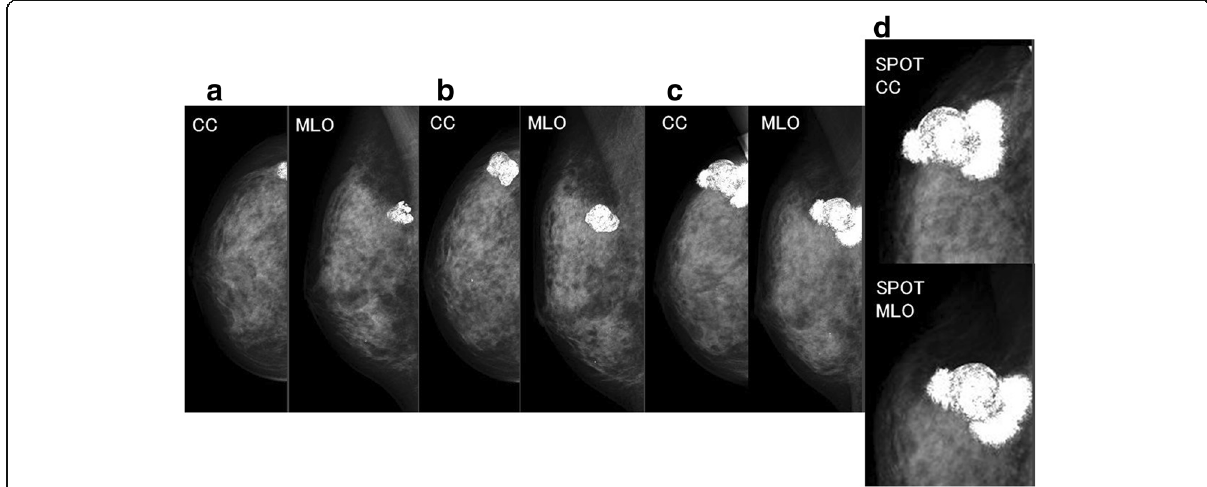
Fig. 1 Mammography. a At the initial visit, it revealed a 1.5-cm coarse heterogeneously high-density calcified lesion at the upper outer portion of the right breast. b About 8 months after our first medical examination, it revealed a slight enlargement of the coarse calcification. c , d About 16 months after our first medical examination, the lesion had grown to 4.5 cm, and new microcalcifications that were fine and irregular in shape and density appeared around the enlarged original coarse calcified tumor